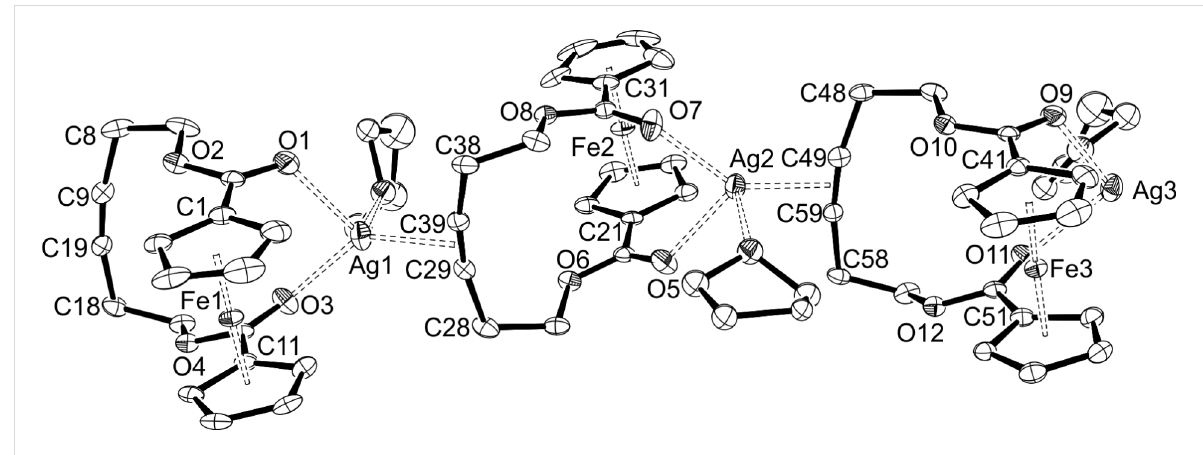
Figure 10: ORTEP diagram of 5 (thf) with thermal displacement drawn at 50% probability; hydrogens atoms, [SbF 6 ] − anions are omitted for clarity, only the main positions of the THF molecules are shown. Selected bond lengths [Å] and angles [°] are given in Supporting Information File 1, Tables S1 and